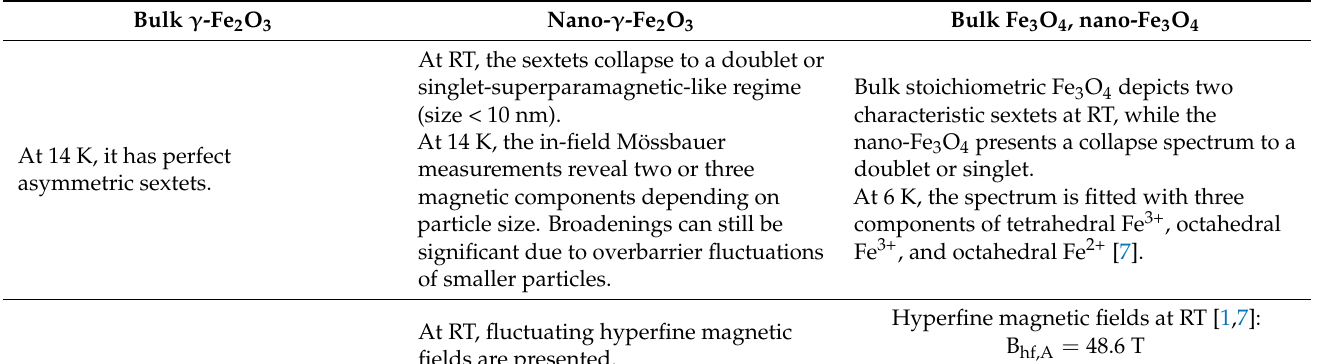
Table 2. Hyperfine parameters obtained from Mössbauer technique for bulk and nano γ -Fe 2 O 3 /Fe 3 O 4 . RAA denotes the relative absorption